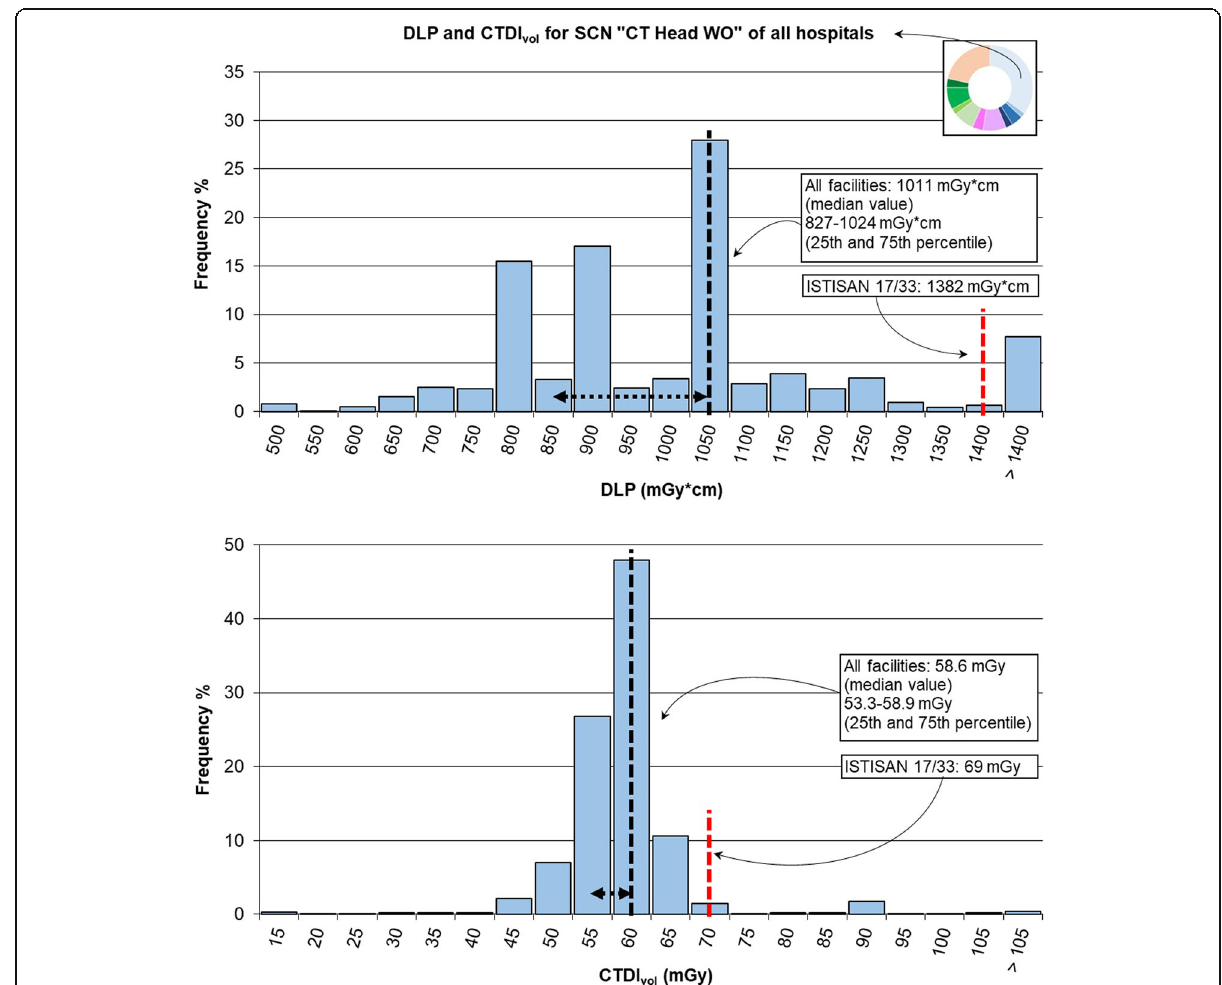
Fig. 4 Distribution of total dose-length product (DLP) and volumetric computed tomography dose index (CTDI vol ) for study common name (SCN) “ CT Head WO ” and comparison with values from ISTISAN 17/33 [18]. The median value and range between 25th and 75th percentile are shown in black dashed lines; the red dashed line reports the diagnostic reference level (DRL) provided by ISTISAN 17/33 [18]. The narrow shape of CTDIvol histogram points out similar values among scanners and highlights the use of fixed mAs values. The DLP histogram shows several peaks. On the one hand, the anatomical region was very similar from one patient to another; on the other hand, the scanners used different collimations, and therefore, the entire anatomical range is covered by a fixed and scanner-dependent number of acquisitions (axial mode). The final peak, more or less evident in all distributions (see the following Figs. 5, 6, 7, 8, and 9), is caused by the inclusion in the last class of values higher than the considered range